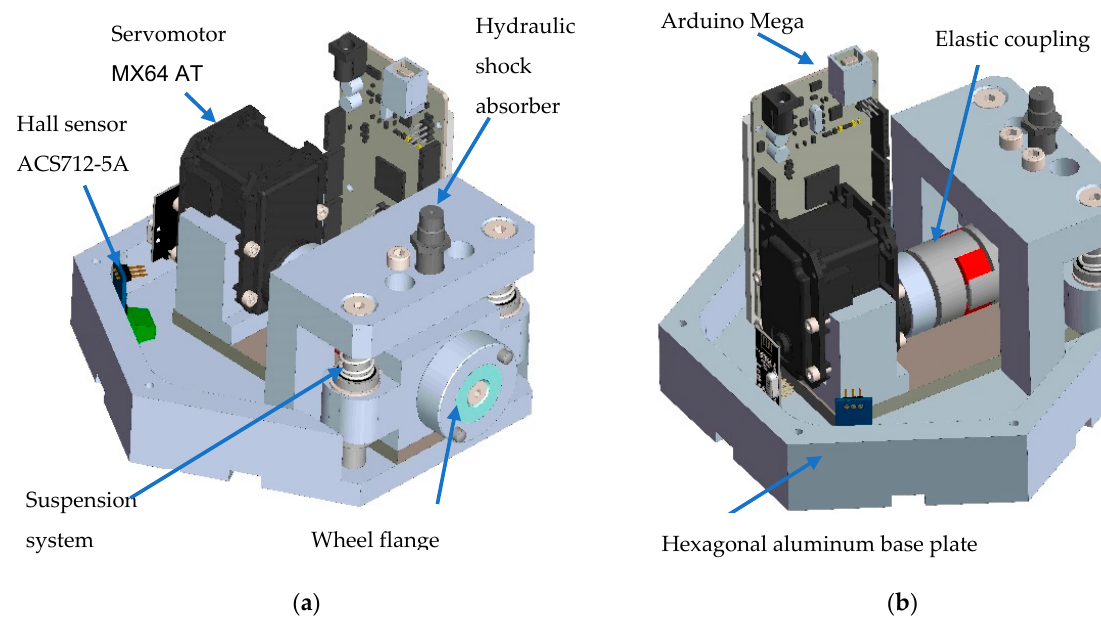
( b ) Figure 6. Drive wheel module assembly (physical model). ( a ) Internal view. ( b ) External view. The electrical components of the drive system are shown in Figure 7. It can be seen that each electrical system of the drive wheel module contains an Arduino Mega develop- ment board that communicates with the control boards in the main control module. The wheel is actuated with an MX64 AT servomotor that was previously chosen based on cal- culations in static and dynamic regimes of the required and maximum torques, respec- tively, and then checked. The main characteristics of the motor are detailed in Table 3. The servomotor has its own driving system, but in this application, an external VNH5019